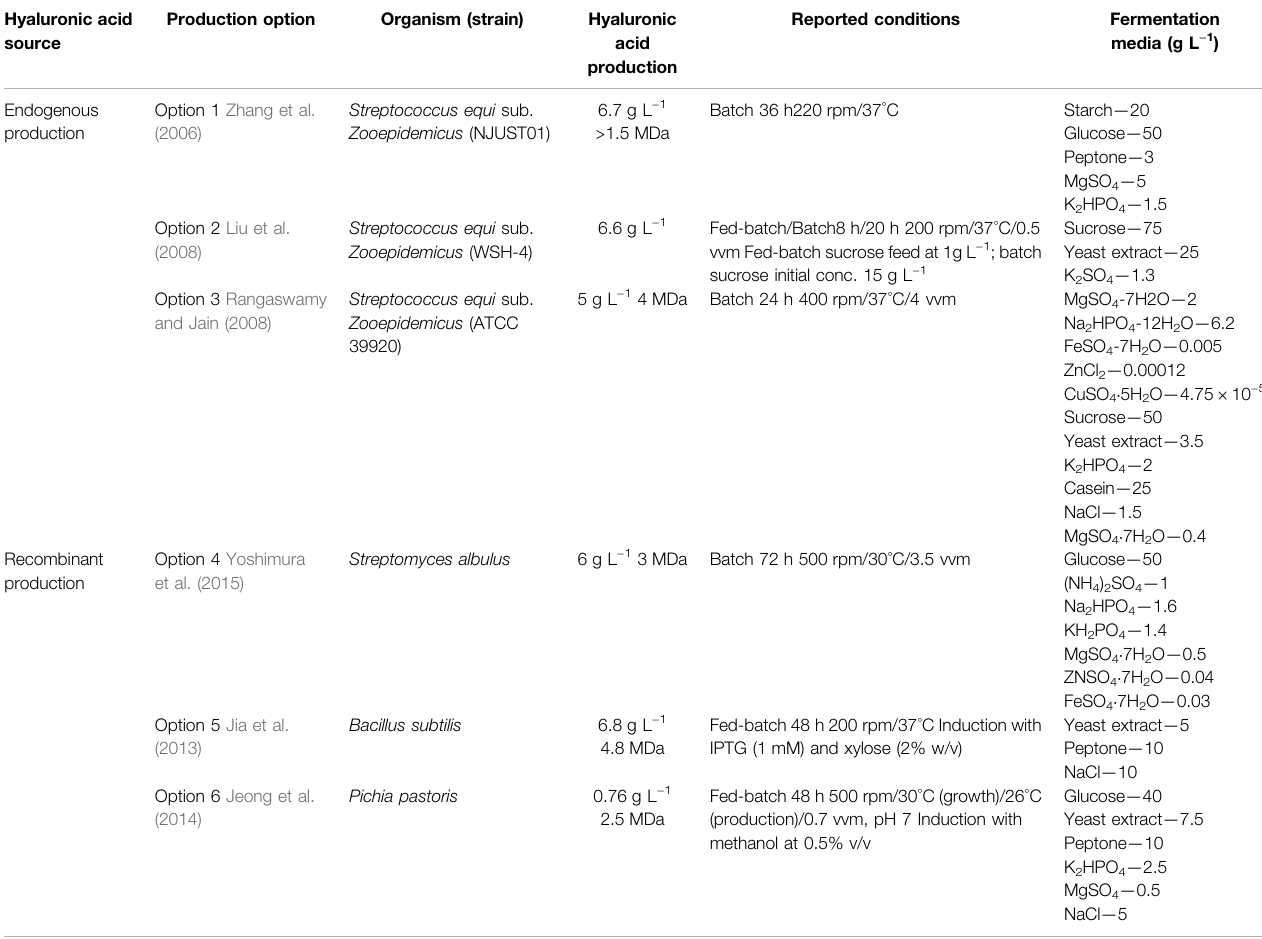
TABLE 1 | Data from hyaluronic (HA) acid upstream processing reports used for model construction. Data includes HA source, production results, reported conditions and fermentation